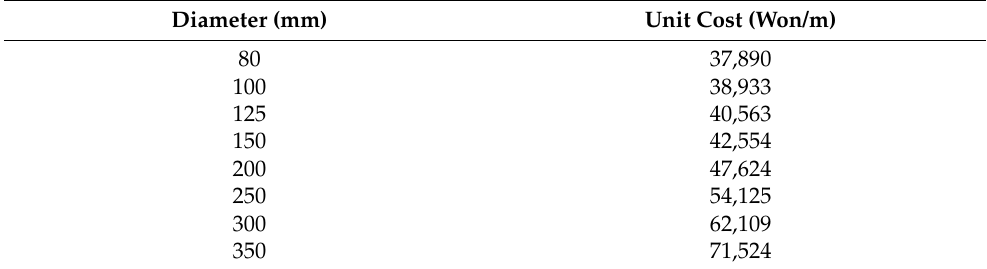
Table 10. Available pipes for selection for the GoYang network.